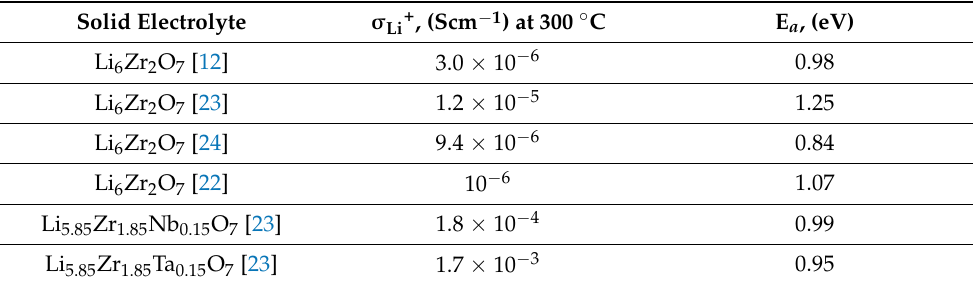
Table 1. Transport properties of Li 6 Zr 2 O 7 and its solid solutions. Solid